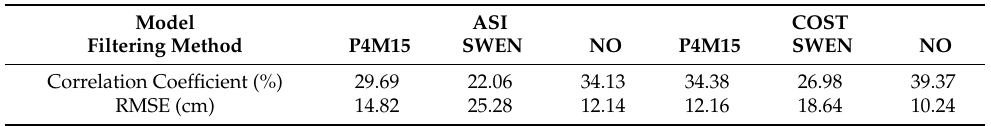
Table 12. The average results of Swarm-TWSC of different filtering methods compared with GRACE- TWSC in 26 basins.